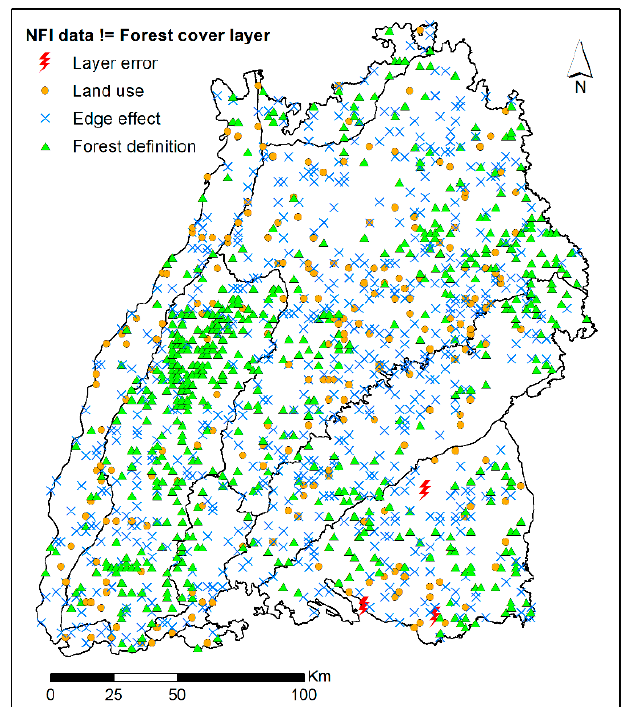
Figure 8. Spatial distribution of the incongruent NFI plots.